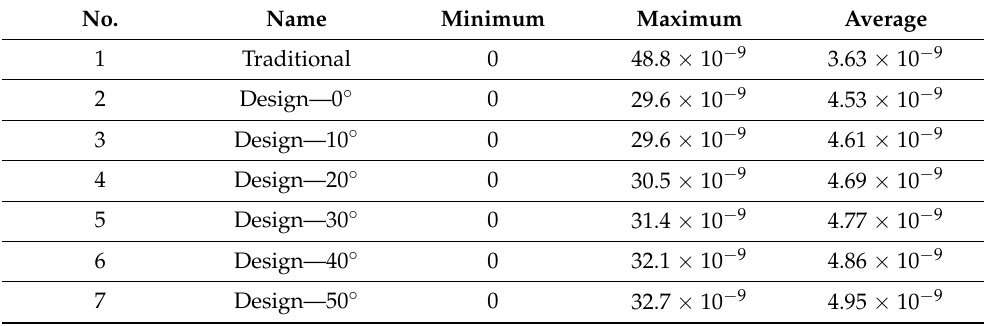
Table 2. Total displacement (m) of each plate.